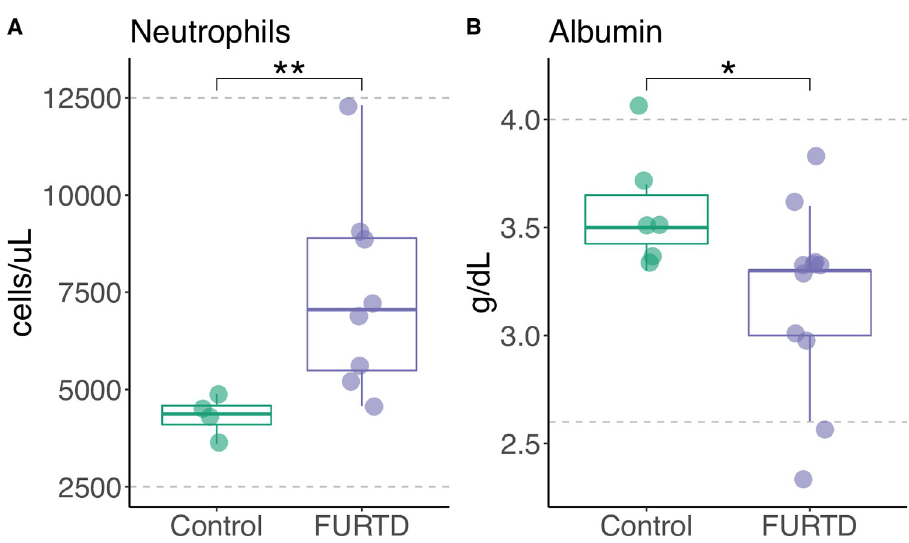
Fig 1. Markers suggestive of inflammation correlate with FURTD status. Absolute number of neutrophils (1A) and albumin levels (1B) are displayed for FURTD and control individuals. Laboratory reference ranges are indicated by grey dashed lines. Significance between groups is indicated by